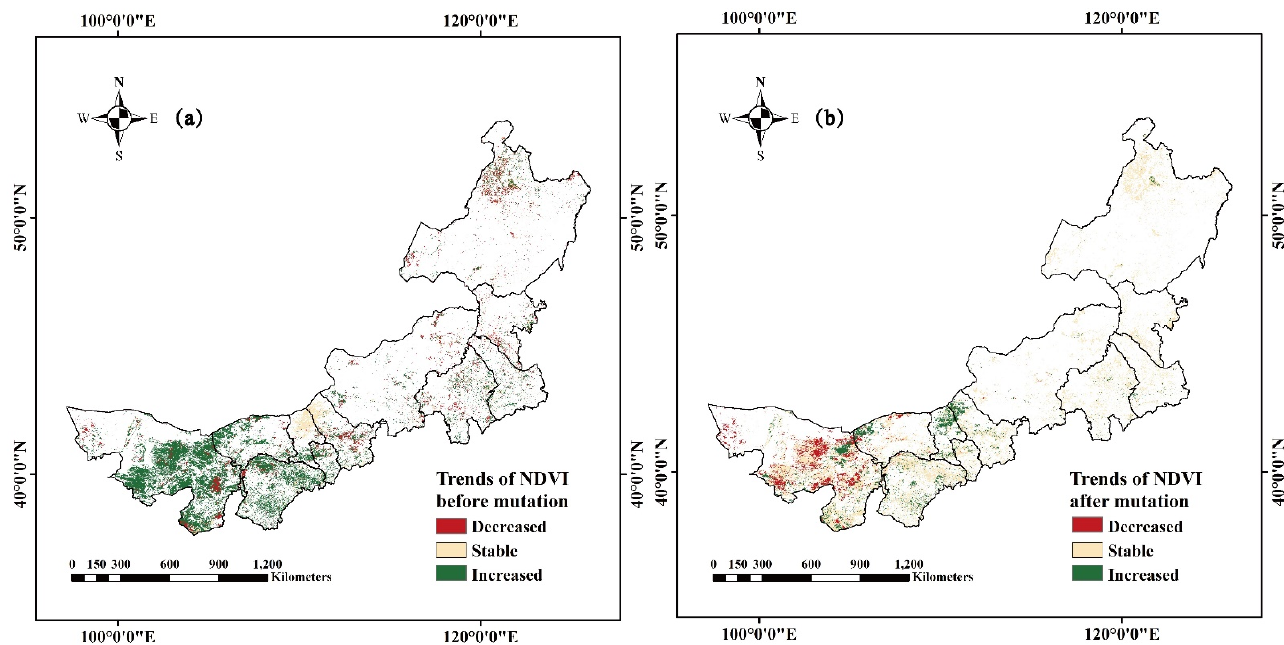
Figure 7. Spatial distributions of trends before and after mutation in Inner Mongolia during 2000–2019. ( a ) trends of NDVI before mutation, ( b ) trends of NDVI after mutation.